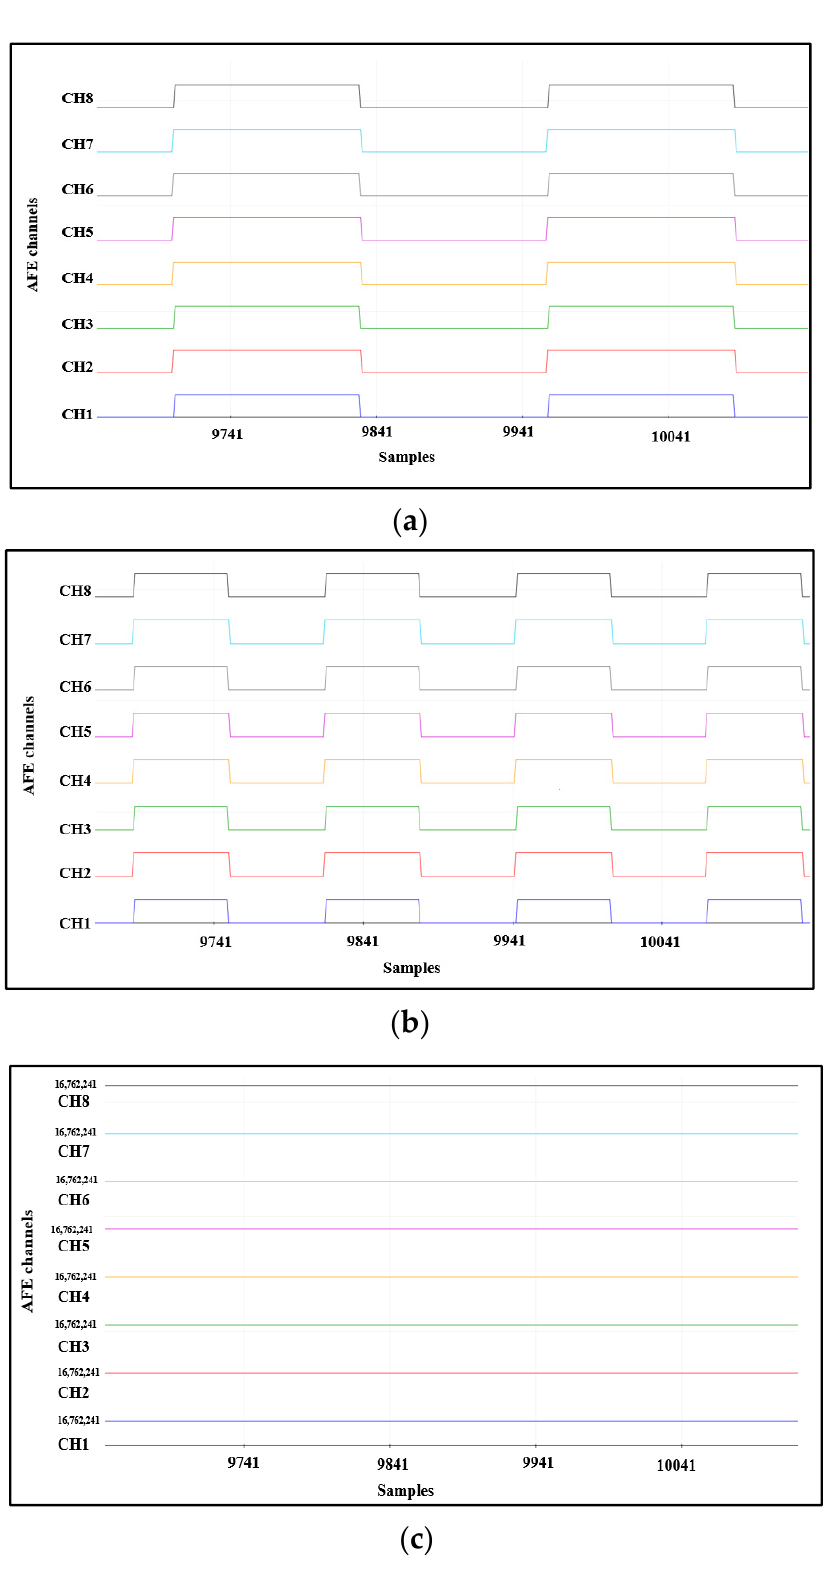
Figure 8. AFE internal test signals: ( a ) square wave with a frequency of 1 Hz, ( b ) square wave with a frequency of 2 Hz, and ( c ) DC mode output to give a constant voltage at each channel.